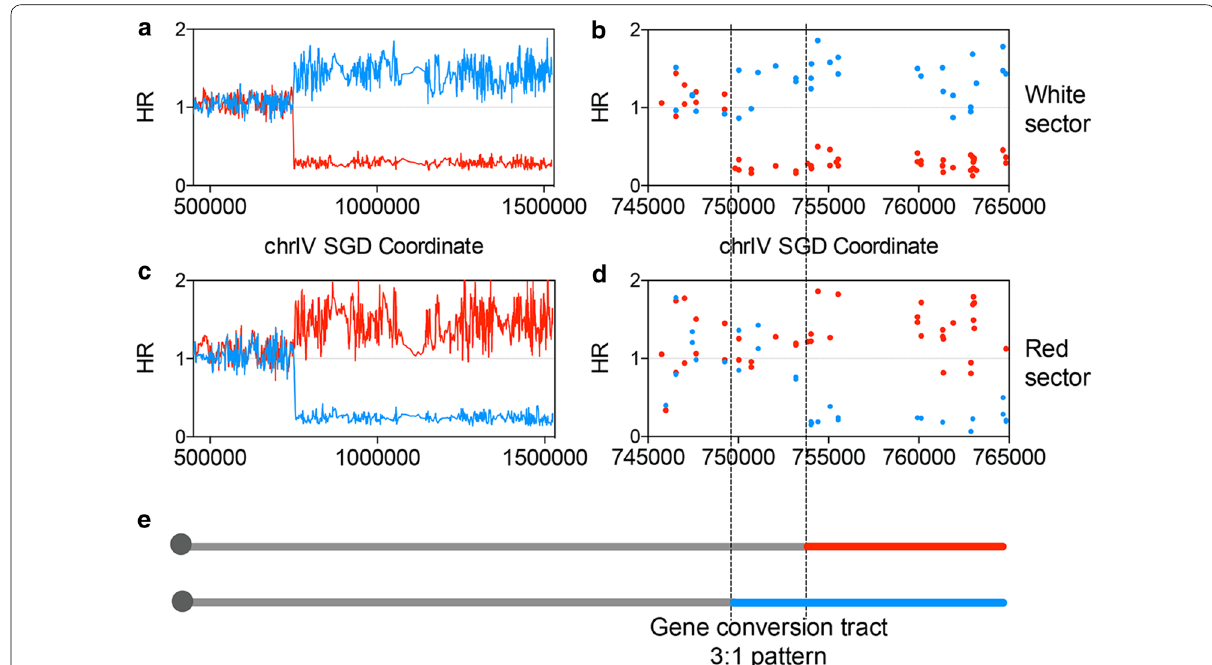
Fig. 2 Analysis of crossover events by chr IV‑specific SNP microarray. The Y‑axis values show the normalized hybridization ratio (HR) of genomic DNA to oligonucleotides that are specific to W303‑1A‑ and YJM789‑derived SNPs. The X‑axis values indicate the SGD coordinates of the SNPs. The hybridization ratio values of about 0.2, 1, 1.5 represent 0, 1, and 2 homolog copies, respectively. The red and blue lines/points indicate the HR of W303‑1A‑ and YJM789‑derived SNPs, respectively. The analysis results of the white sector and the red sector are shown in a and b at low resolution; the high‑resolution results are shown in c and d . e The gene conversion tract pattern associated with this crossover